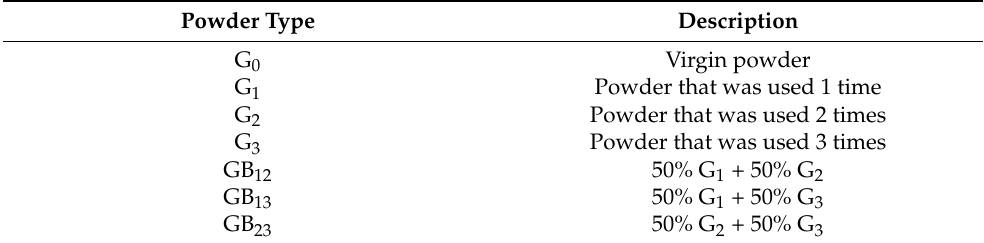
Table 2. Nomenclature and description of the various powder types investigated for the current study. Powder